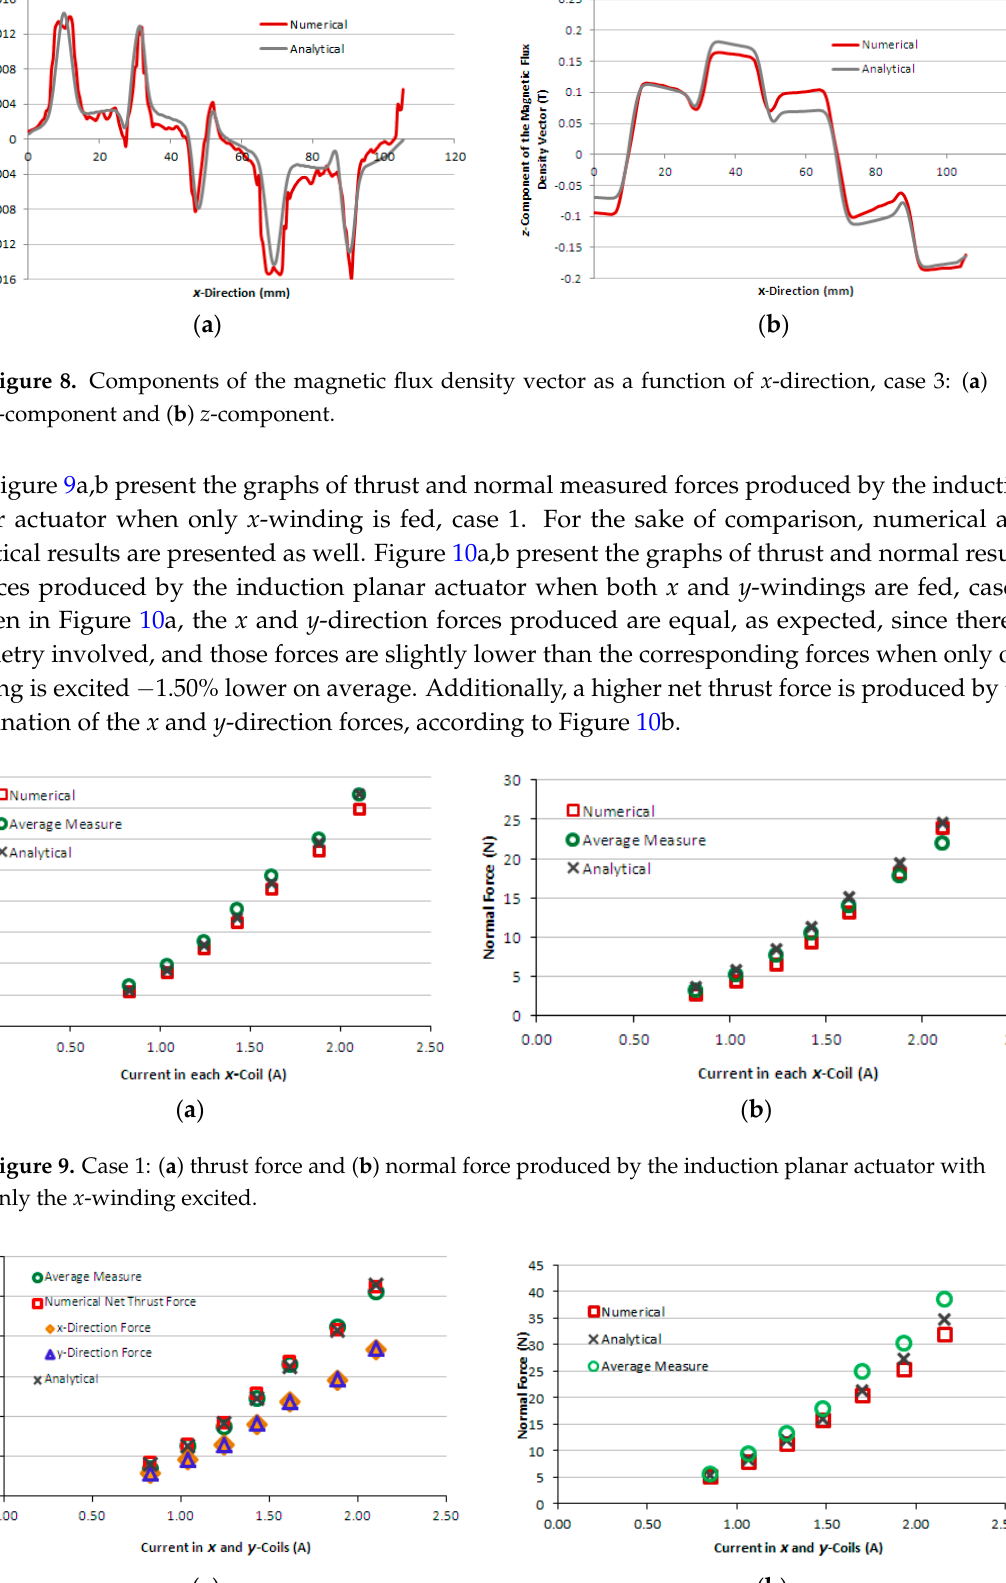
Figure 7. Components of the magnetic flux density vector as a function of x -direction, case 2: ( a ) x -component and ( b ) z -component.